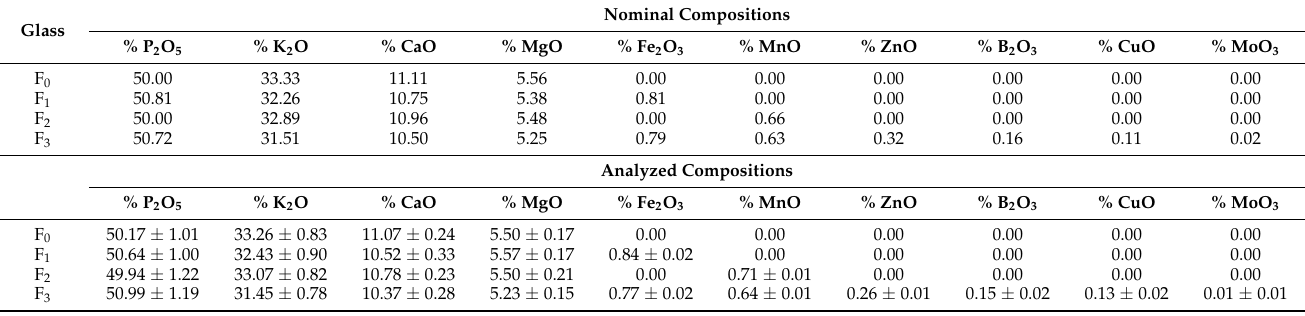
Table 1. Nominal and analyzed compositions of the vitreous fertilizers.